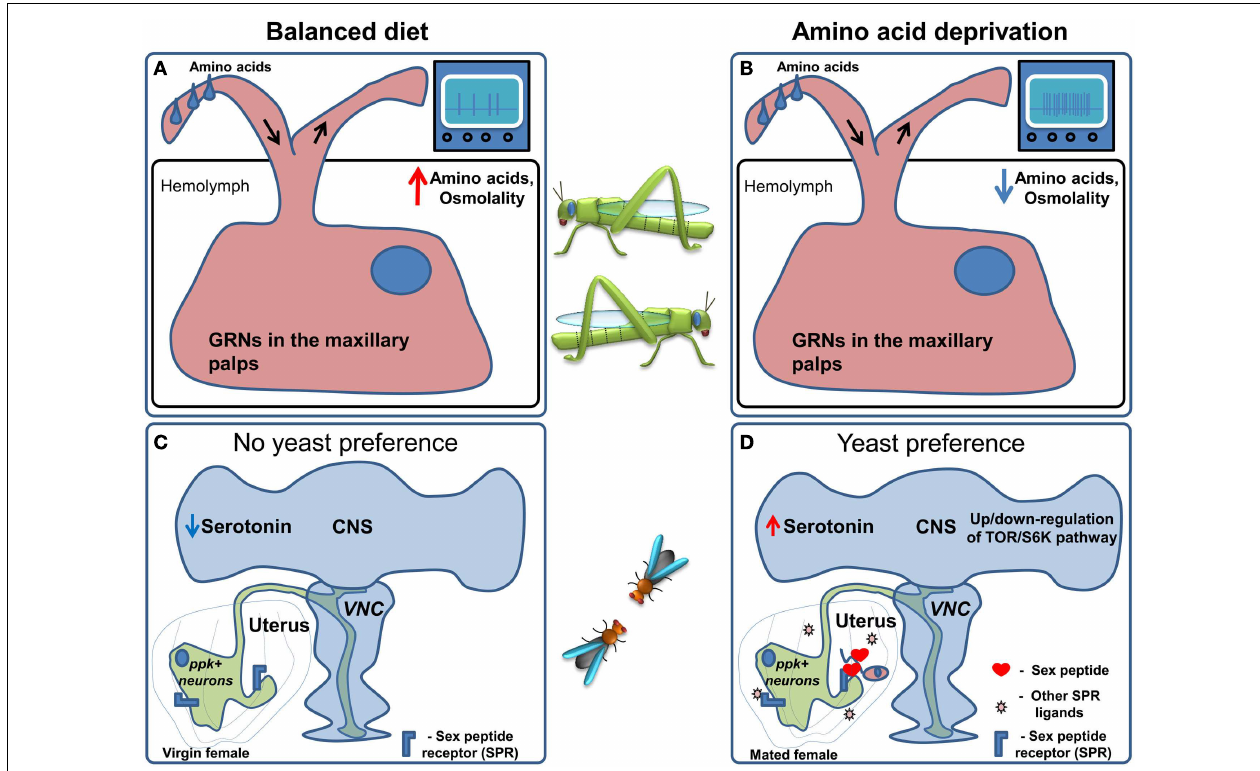
deprived of amino acids, it is conceivable that,TOR/S6K signaling in neurons is altered presumably indicating an internal amino acid deficiency and serotonin levels in the brain are thought to increase. Furthermore, upon mating Sex Peptide, as well as other ligands of the Sex Peptide receptor, are transferred to the uterus causing the inhibition of the ppk + neurons which project to theVentral Nerve Cord (VNC) and the brain.These changes lead to an increase in yeast (amino acid rich food)